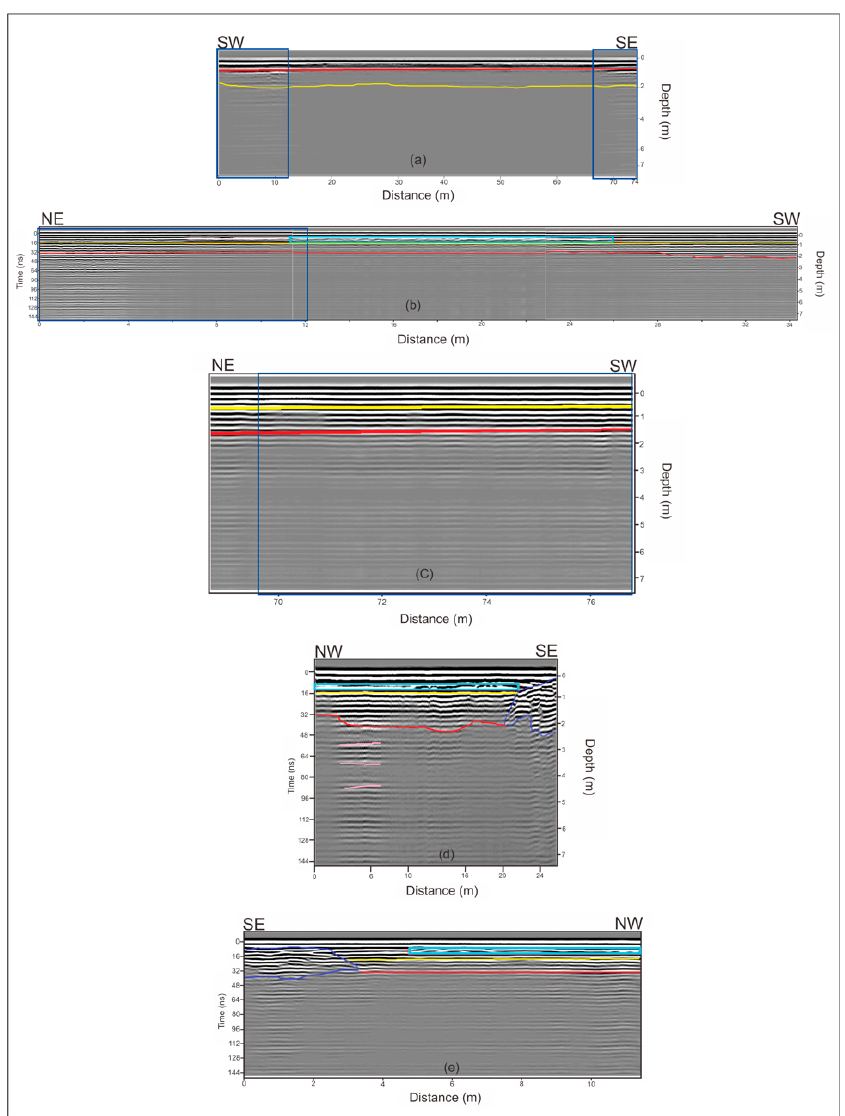
Figure 5. GPR profiles at site 1, Batu Ferringhi Beach, representing natural coastal landform. ( a ) Line 1-Anomalies in between 12 m and 68 m as indicated by attenuation until lost radar signal is due to the existing public toilet, its underground pipeline system, and well; ( b , c ) Line 2–a 0.5 m thick compact layer detected along with the distance of 6.5 to 26.5 m, interpreted as a saturated zone. In correspond with line 1, the interpreted dry condition zone is marked in between 0–12 m and 69–76 m; ( d ) Line 3–starts from the distance of 21 m shows sediments inclination upwards due to the man-made structure which may have been disrupted the wave activity; ( e ) Line 4–also shows the indication of the man-made form at a depth of <1.5 m and <2.5 m respectively connect to the features as delivered in line 3—all saturated zones marked by cyan boxes, while dry sediments marked by blue boxes. Saturated zones interpreted as groundwater level estimated approximately at a depth of 1.5 m.